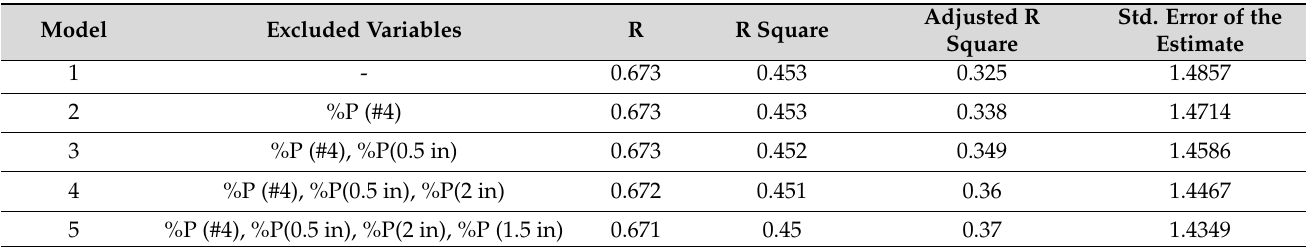
Table 8. Details of the MLR models developed for the OMC during the backward elimination process.